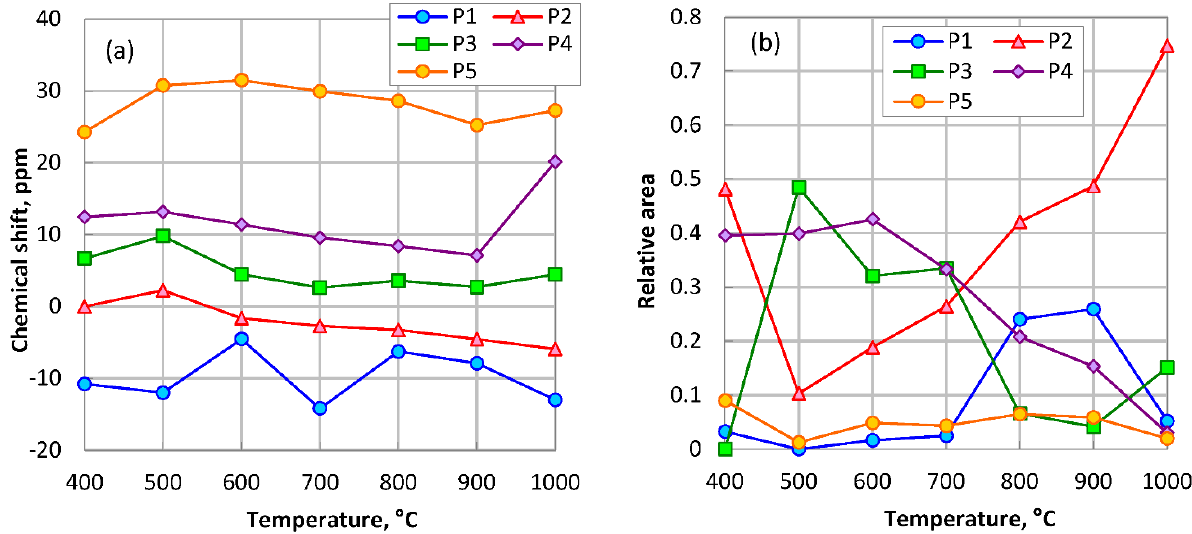
Figure 8. Chemical shift ( a ) and relative area ( b ) of deconvoluted components of 31 P MAS NMR spectra of polyimide-derived carbons obtained with phosphoric acid (H 3 PO 4 -series) at different temperatures.